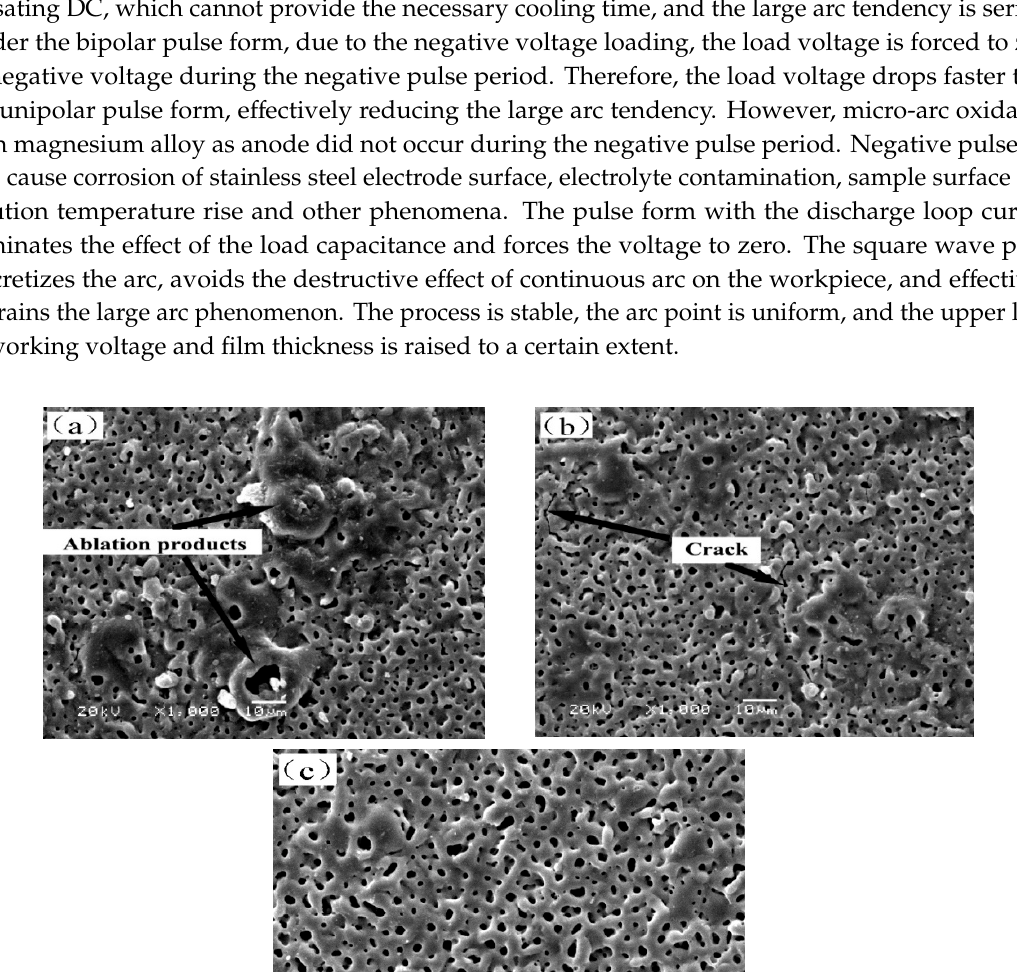
Figure 5. The XRD patterns of the MAO coatings using pulsed bipolar current and the pulsed with a discharge loop current power supply mode.